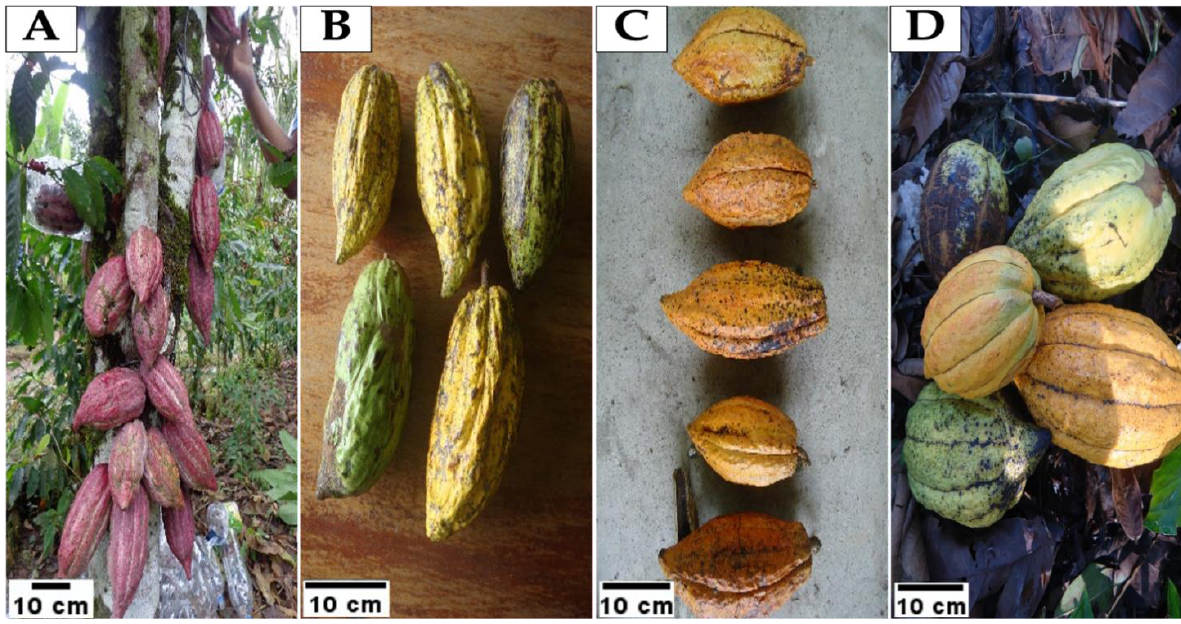
Figure 1. Geographical sites (red dots) where cacao’s leaves were collected in Honduras.